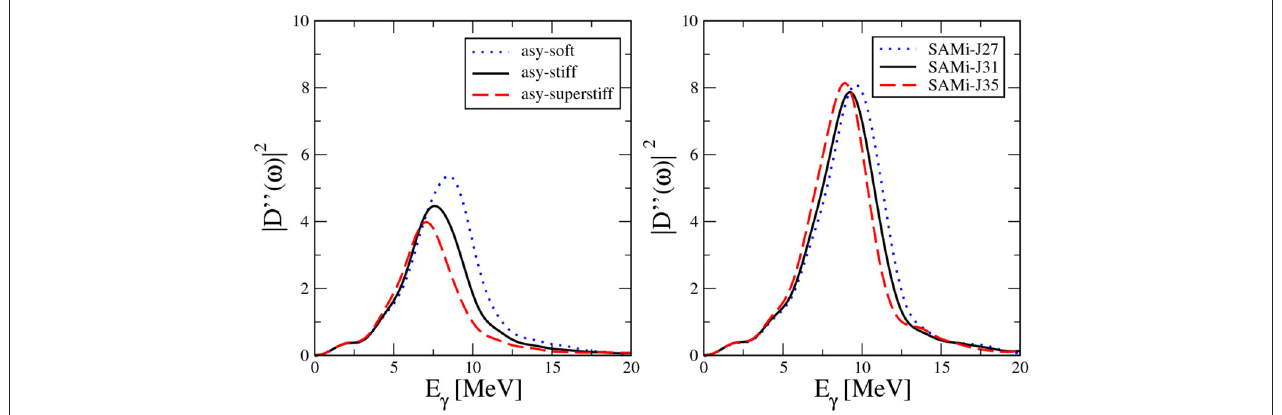
FIGURE 10 | (Color online) Power spectrum of the dipole acceleration as obtained by employing MI (Left) or MD (Right) interaction, for f cs = 1 and b = 2 fm (see text). Readapted from Zheng et al.